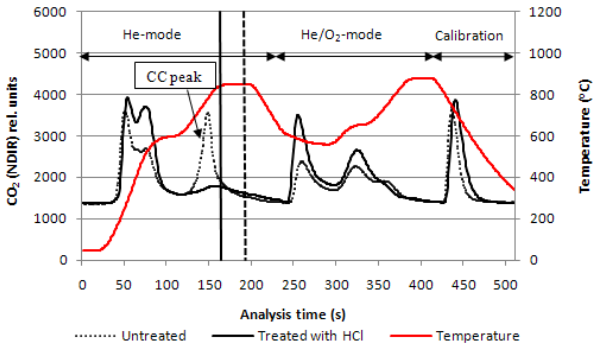
Fig. 7. RT-QUARTZ-840 thermogram for an ambient aerosol sam- ple filter treated with HCl and untreated (He-mode: 1–230s, He/O 2 - mode: 231–410s and Calibration-mode: 410–510s). The vertical lines represent the splint point between OC and EC. The response of the NDIR detector is given in relative